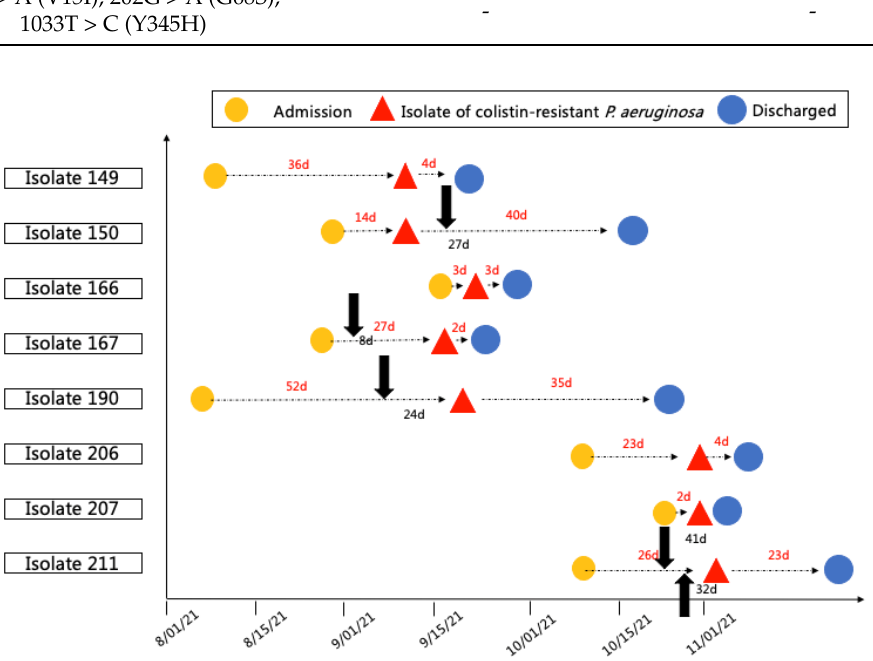
Figure 1. Timeline for the isolation of polymyxin-resistant P. aeruginosa . The red triangles show the time polymyxin-resistant P. aeruginosa was isolated. The black arrows show when polymyxin B treatment commenced.